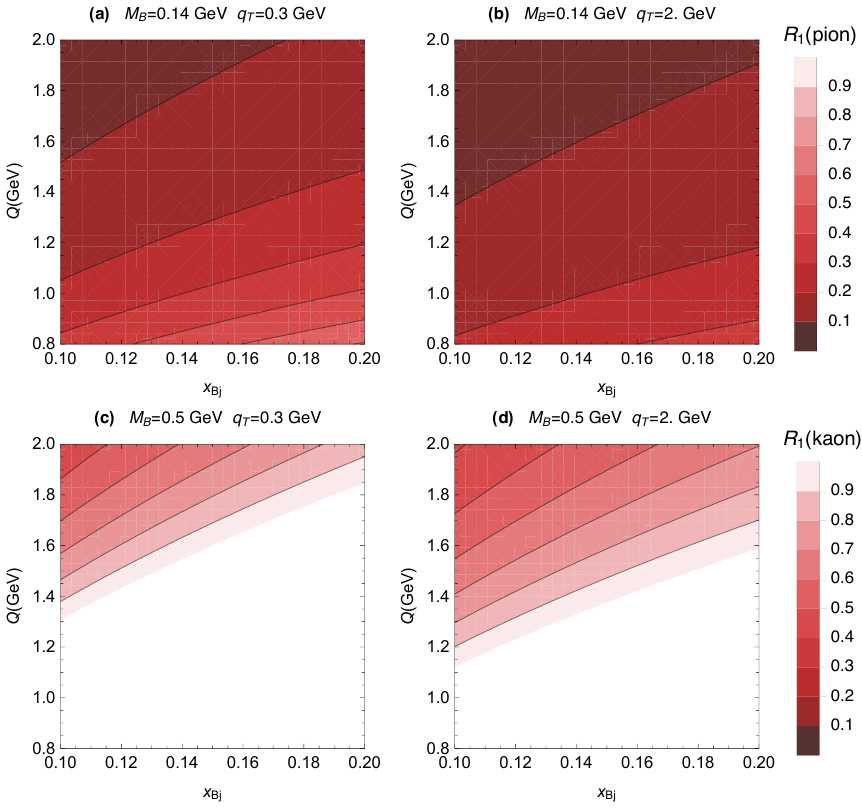
Figure 10 . Collinearity ( R 1 from eq. (4.15) for (cid:12)xed z h = 0 : 25, (cid:16) = 0 : 3 and (cid:24) = 0 : 2. Top panels show the ratio for M B = m (cid:25) at (a) small transverse momentum ( q T = 0 : 3 GeV) and (b) q T = 2 : 0 GeV. Similar cases for M B = m K are shown in the bottom panels, (c) and (d).